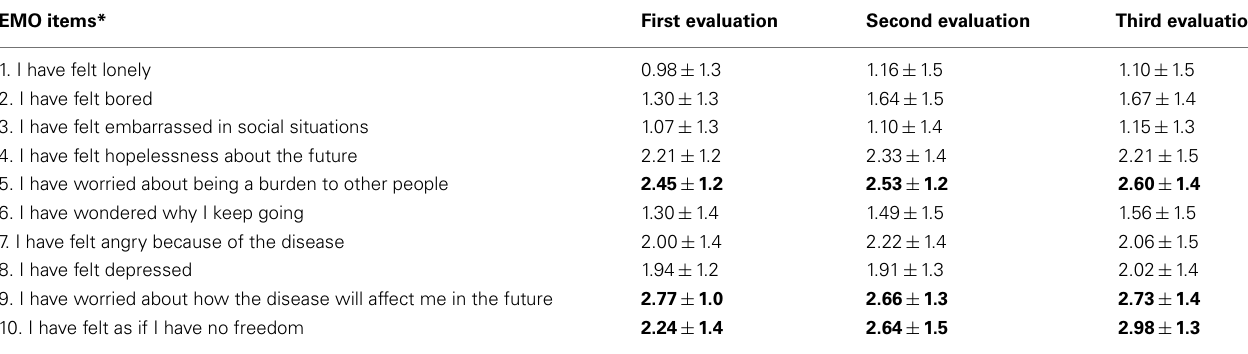
Table 3 | Mean scores and SD of EMO items at the three